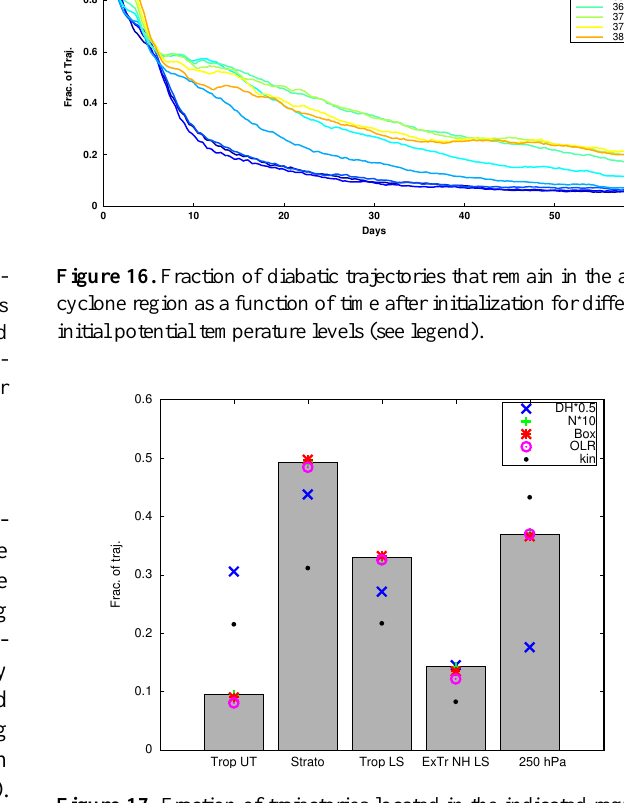
Figure 17. Fraction of trajectories located in the indicated regions ( x axis) averaged over day 50–60 for a subset of 10 initial starting days between June and August. Shown are results from calculations with diabatic transport (gray bars), kinematic transport (black dot), diabatic heating rates scaled by 0.5 (blue x), number of trajectories increased by a factor of 10 (green cross), initial positions in a box region (red star) and initial positions in low OLR regions (magenta